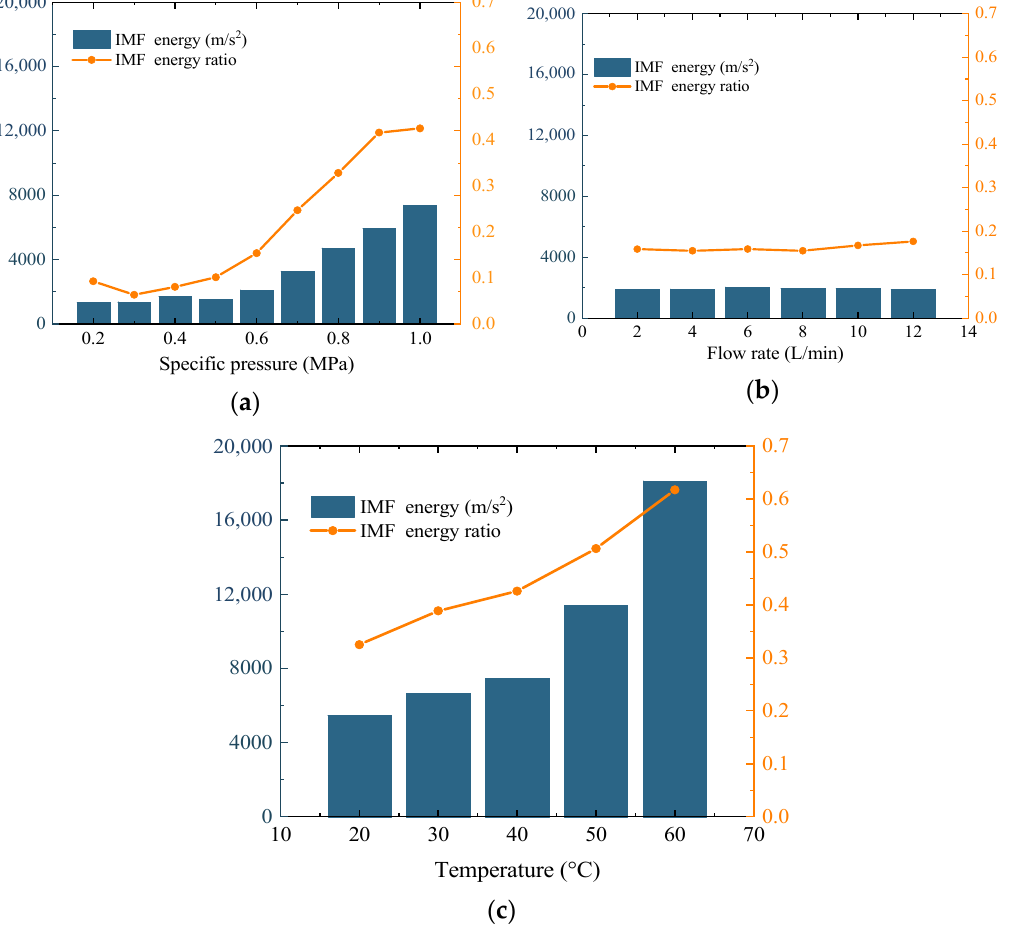
Figure 14. Effect of the specific pressure, flow rate, and temperature on the eigenvalues of IMF. ( a ) Specific pressure, ( b ) flow rate, ( c ) temperature.